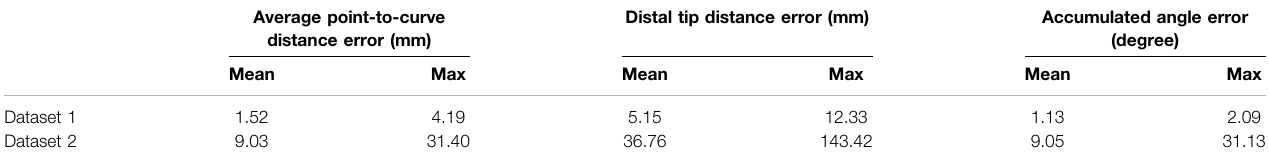
TABLE 3 | Errors of prediction on test sets.